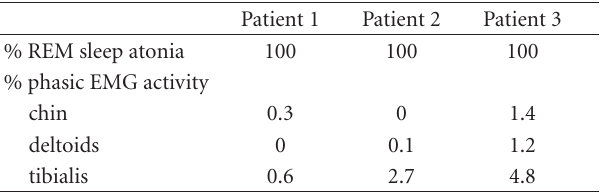
Table 2: Polysomnographic features of REM sleep in